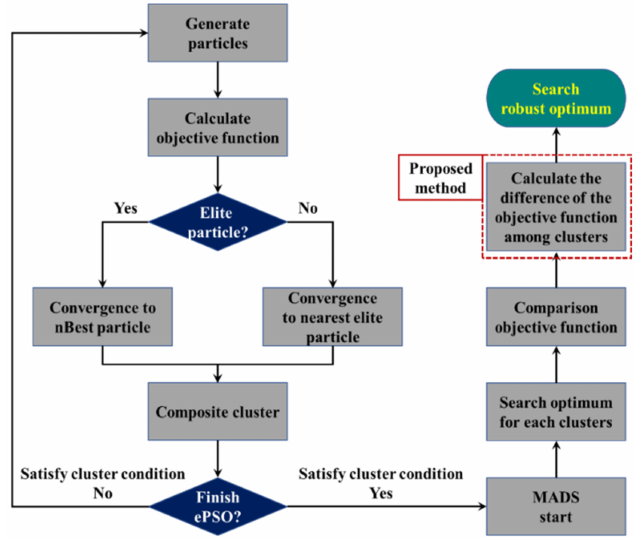
Figure 4. The flow chart of